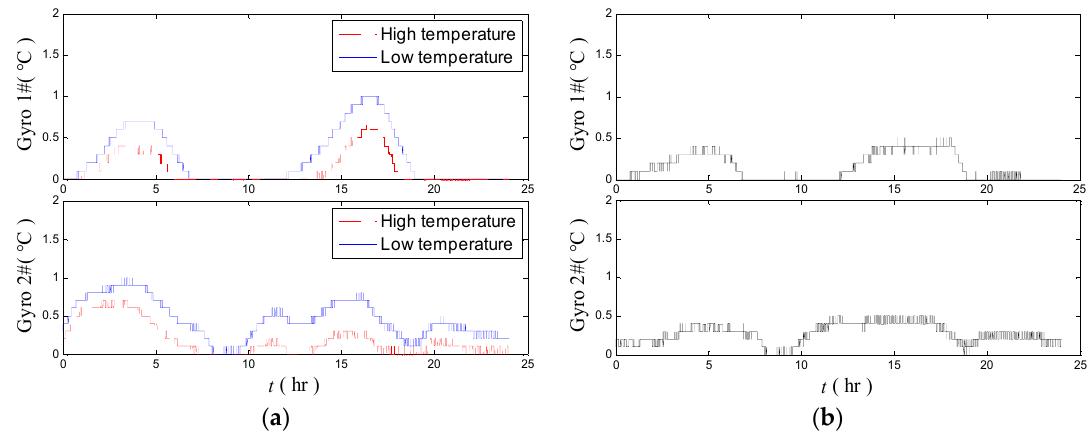
Figure 12. Temperature fluctuation of the gyros in the high–low temperature tests ( a ) and the temperature fluctuation difference of the gyros under high and low temperature tests ( b ) after the evaluation and optimization proposed methods.